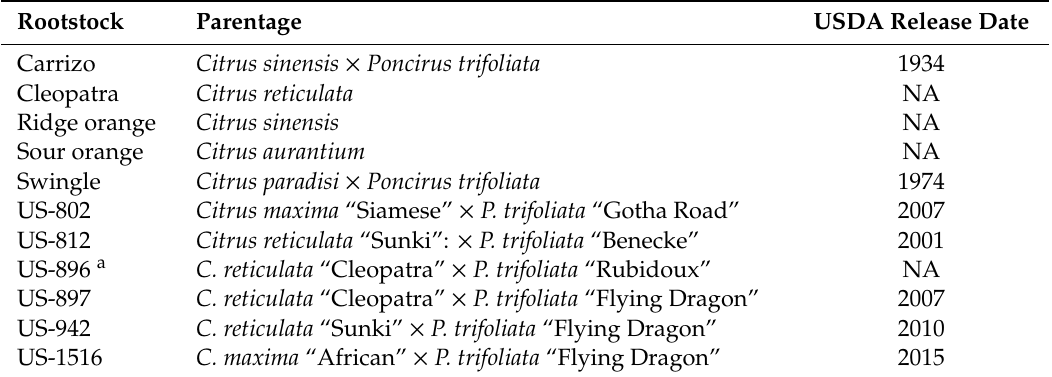
Table 1. Citrus rootstock cultivars used in the study, with parentage and release